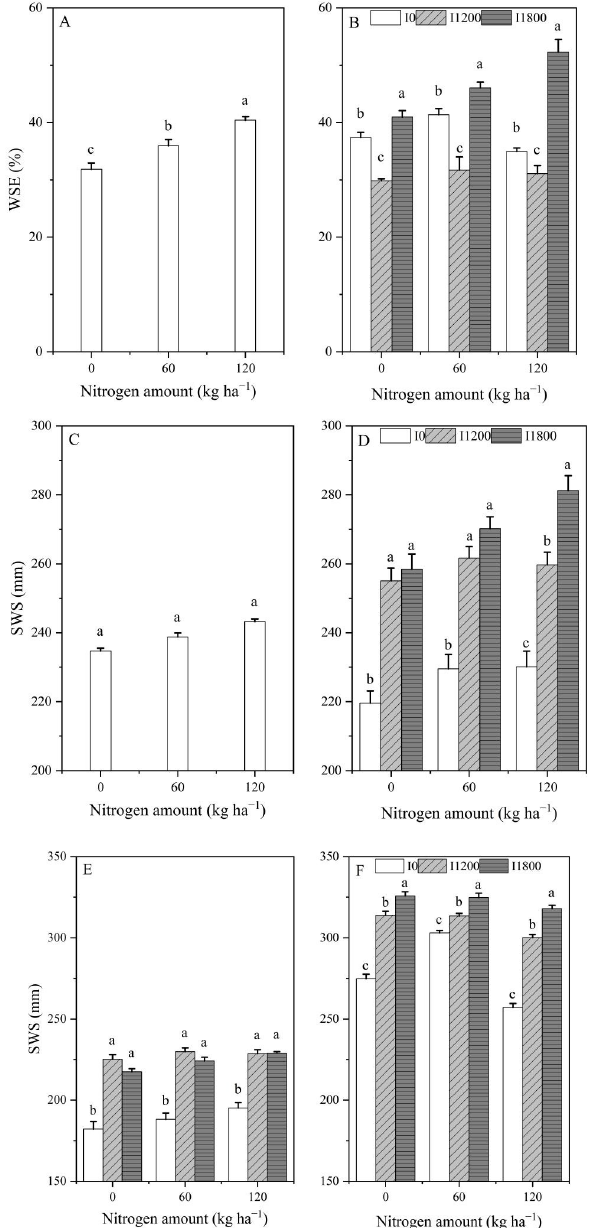
Figure 2. Response of WSE to nitrogen application rate in the 2017 ( A ) and 2018 ( B ); Response of before-sowing SWS to the N application rate in 2017 ( C ) and 2018 ( D ); Response of after-harvest SWS to the N application rate in 2017 ( E ) and 2018 ( F ). Data are averaged across treatments. Error bars show the standard error of the mean. WSE is water storage efficiency (%), SWS is soil water storage (mm). Different lowercase letters represent the least significant difference (LSD) at p < 0.05.